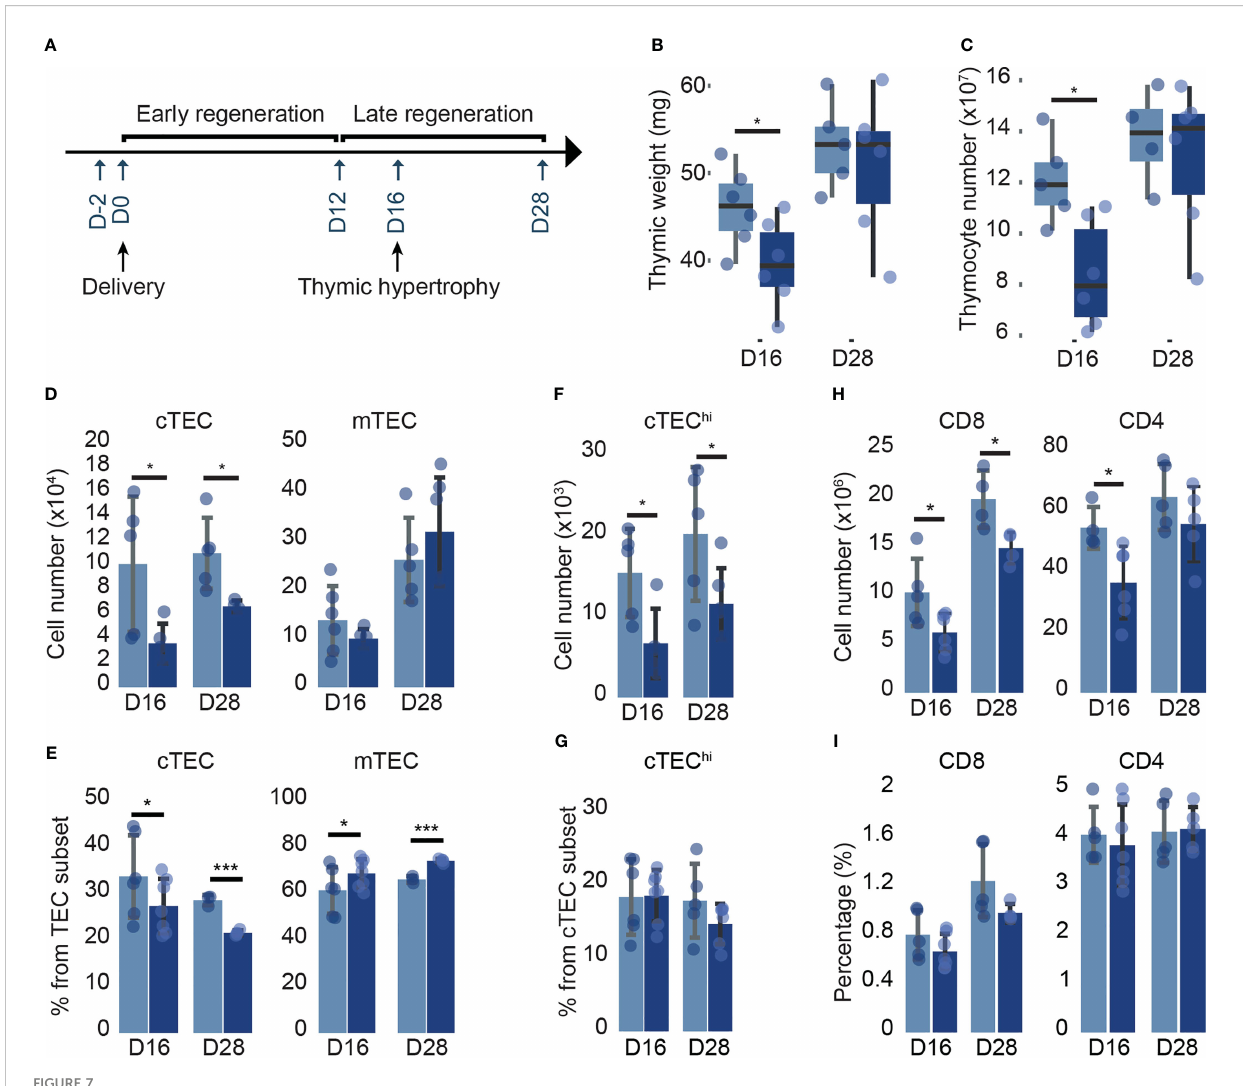
FIGURE 7 Profound modi fi cation in mature cTECs from KO females persists at D28 post-delivery. (A) Timeline of post-partum thymic regeneration. (B, C) Thymic weight (mg) (B) and thymocyte numbers (C) in LOX and KO females (from n=4-6 mice per genotype). (D, E) cTEC and mTEC numbers (D) and proportions (E) in LOX and KO females (n=5-7). (F, G) cTEC hi number (F) and proportion (G) in LOX and KO females (n=4-5). (H, I) Simple- positive CD8 and CD4 thymocyte numbers (H) and proportions (I) in LOX and KO females (n=4-5). All analyses were performed in the thymi of females at D16, and D28 post-delivery tested in two independent experiments. LOX and KO genotypes are displayed in pale blue and dark blue, respectively. Signi fi cance was assessed using an unpaired two-tailed Student ’ s t -test. (* p